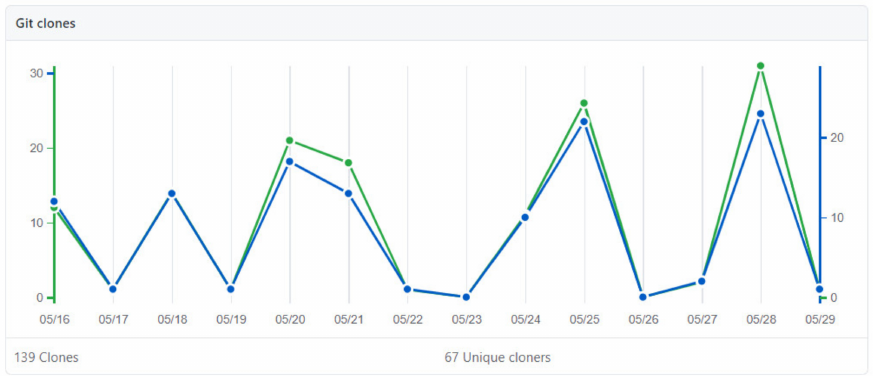
Figure 7. Number of unique clones of COVID-19 Data repository for past 14 days.